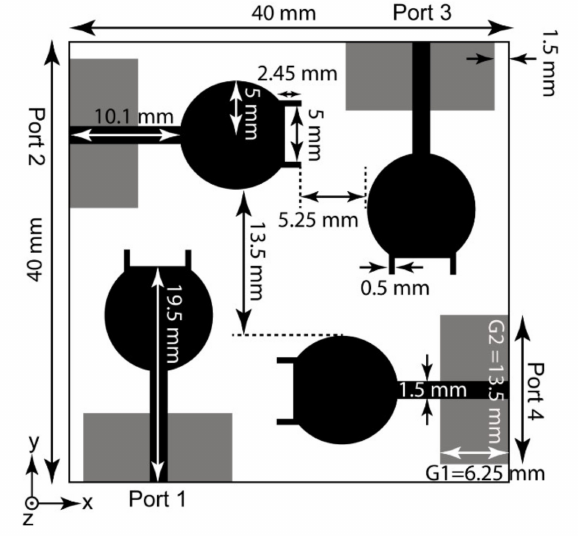
Figure 4. Schematic of the proposed UWB MIMO antenna.